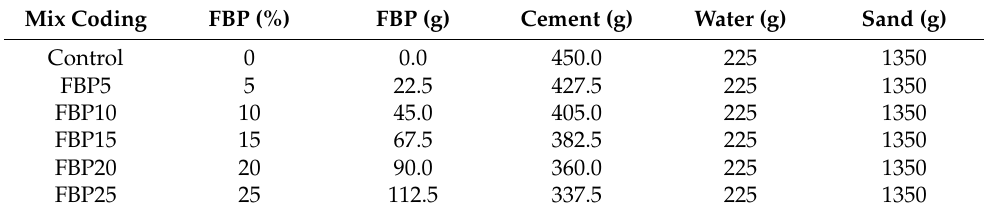
Table 2. Mixing plan of cementitious composite mortars incorporating